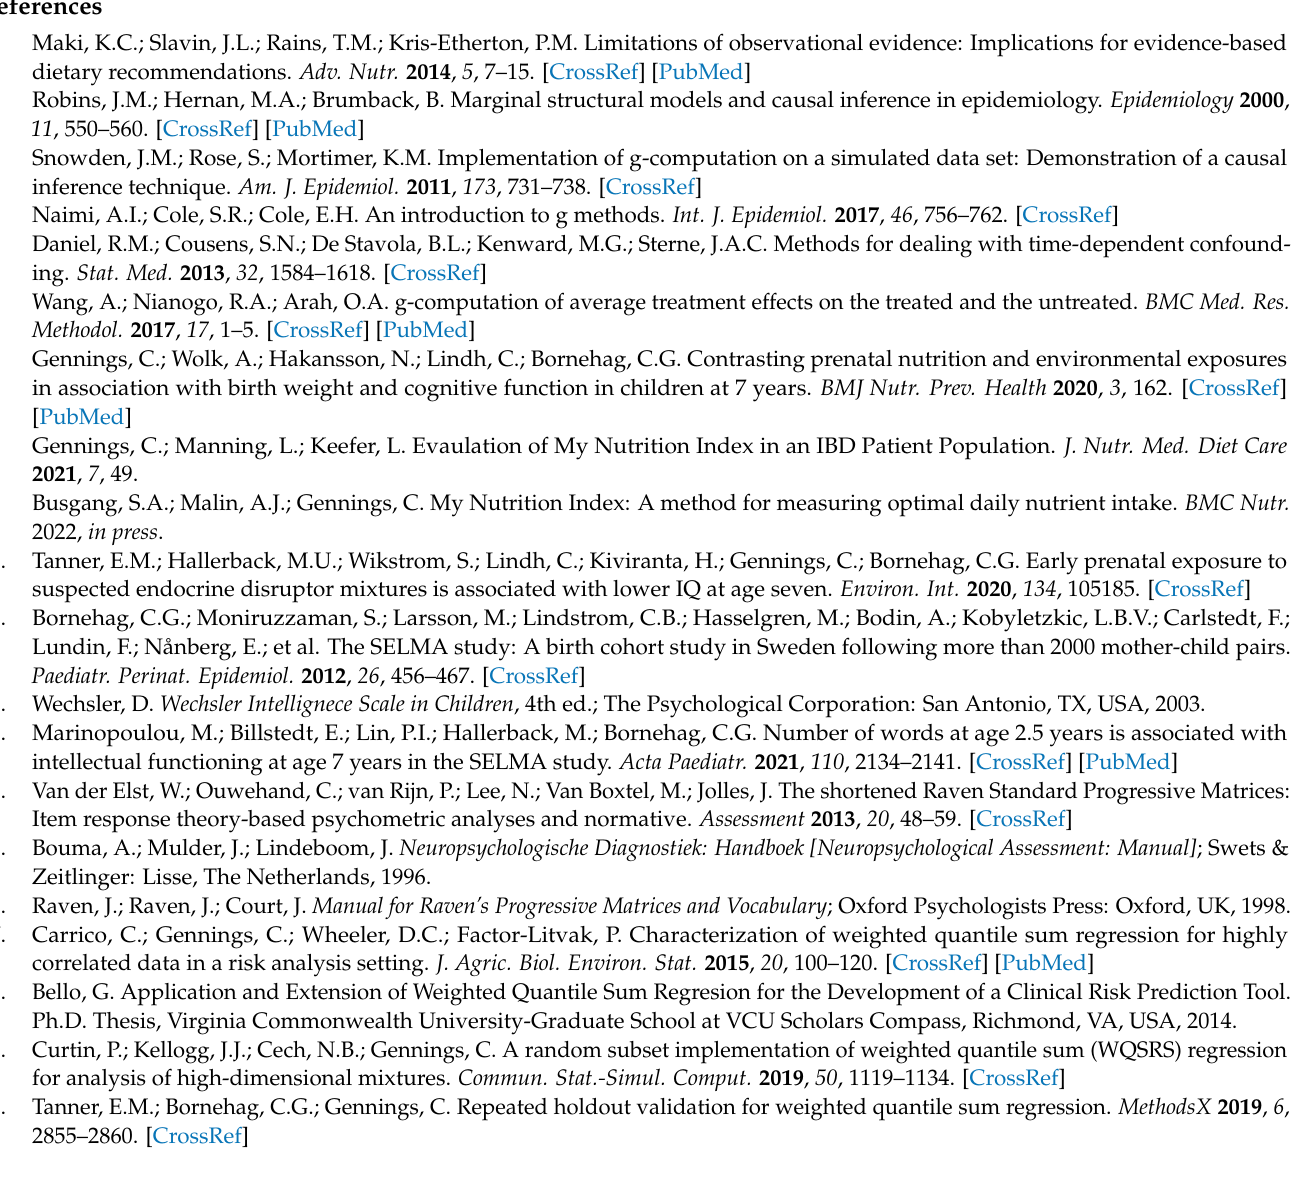
Figure A1. Assumed directed acyclic graph (DAG) for prenatal EDCs and child IQ.